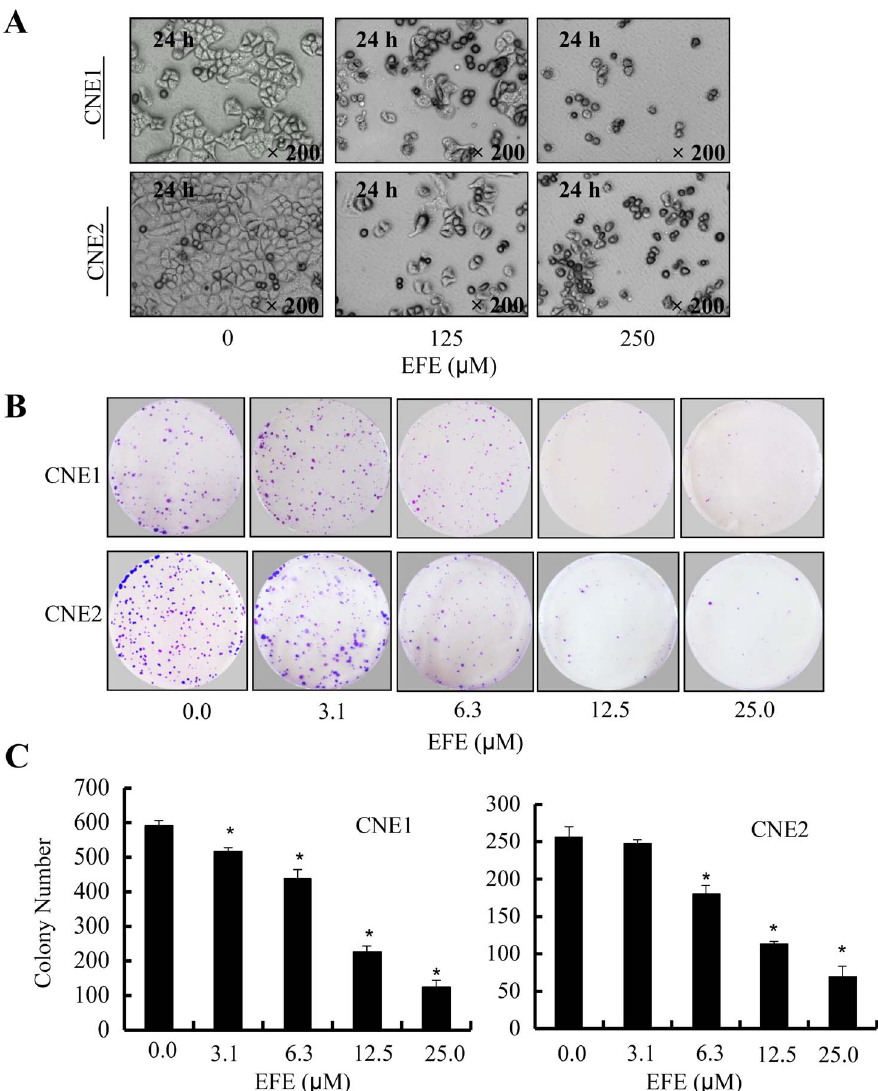
Figure 2. Effusanin E inhibits proliferation of NPC cells in vitro. ( A ) The cell morphology changes of human CNE1 and CNE2 cells after treatment with effusanin E (EFE) at 125 m M or 250 m M. ( B ) Colony formation assay of human CNE1 and CNE2 cells treated with effusanin E (EFE) at 3.1–25.0 m M. Cells were cultured as indicated in 6-well plates and treated with effusanin E for 10 days. After treament, the cells were dyed with crystal violet and took pictures. ( C ) The number of colony formation assay. The grown colonies of colony formation assay were scored. The data are presented as the mean 6 SD of three separate experiments. * represent P , 0.05.